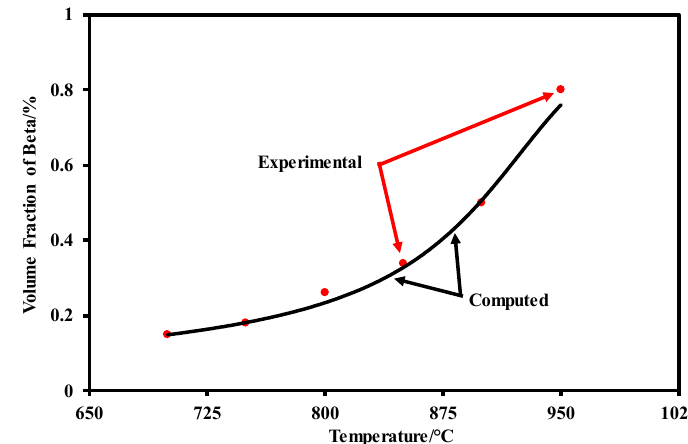
Figure 9. Comparison of volume fraction β phase evolution between experimental (symbols) and computed (solid curves) strain-stress during hot stamping TA15 at different temperatures.